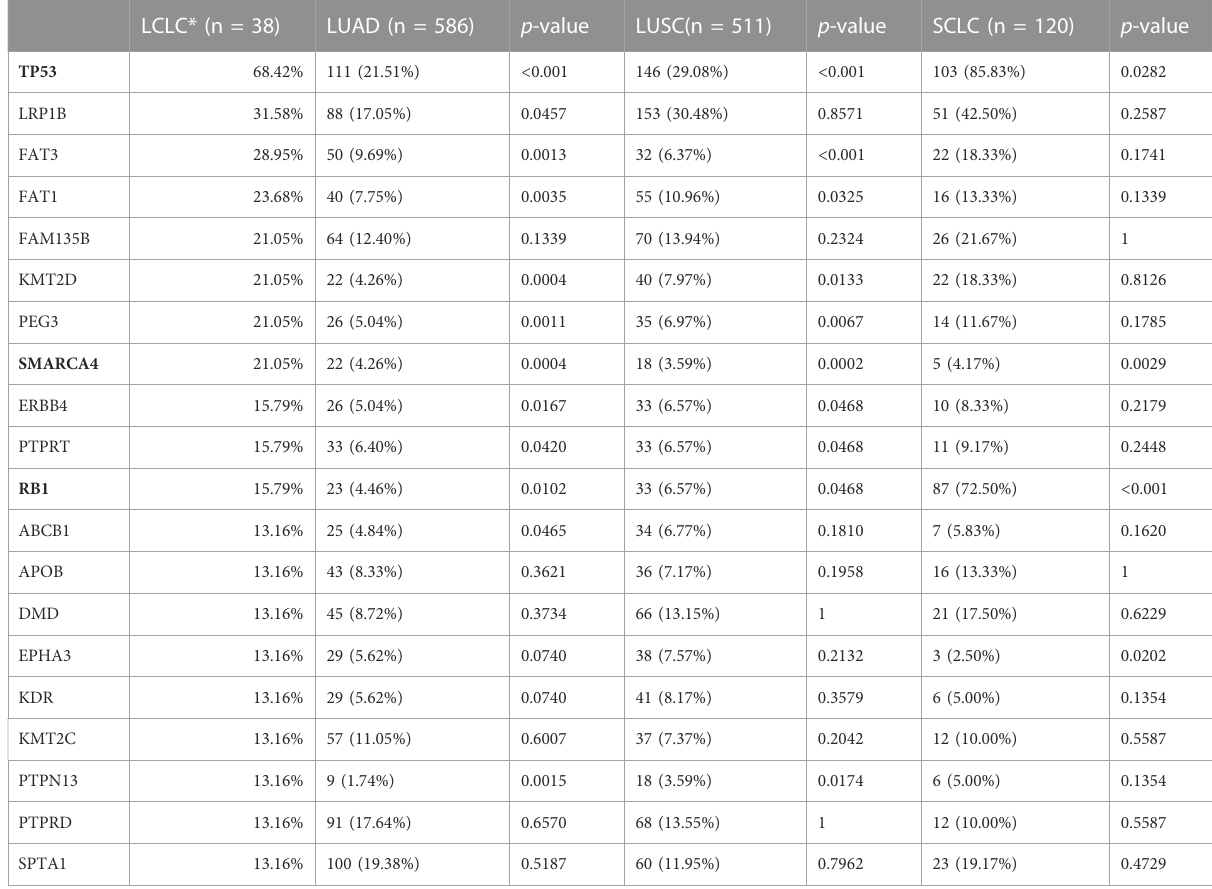
TABLE 2 Comparison of TOP20 driver genes in different lung cancer